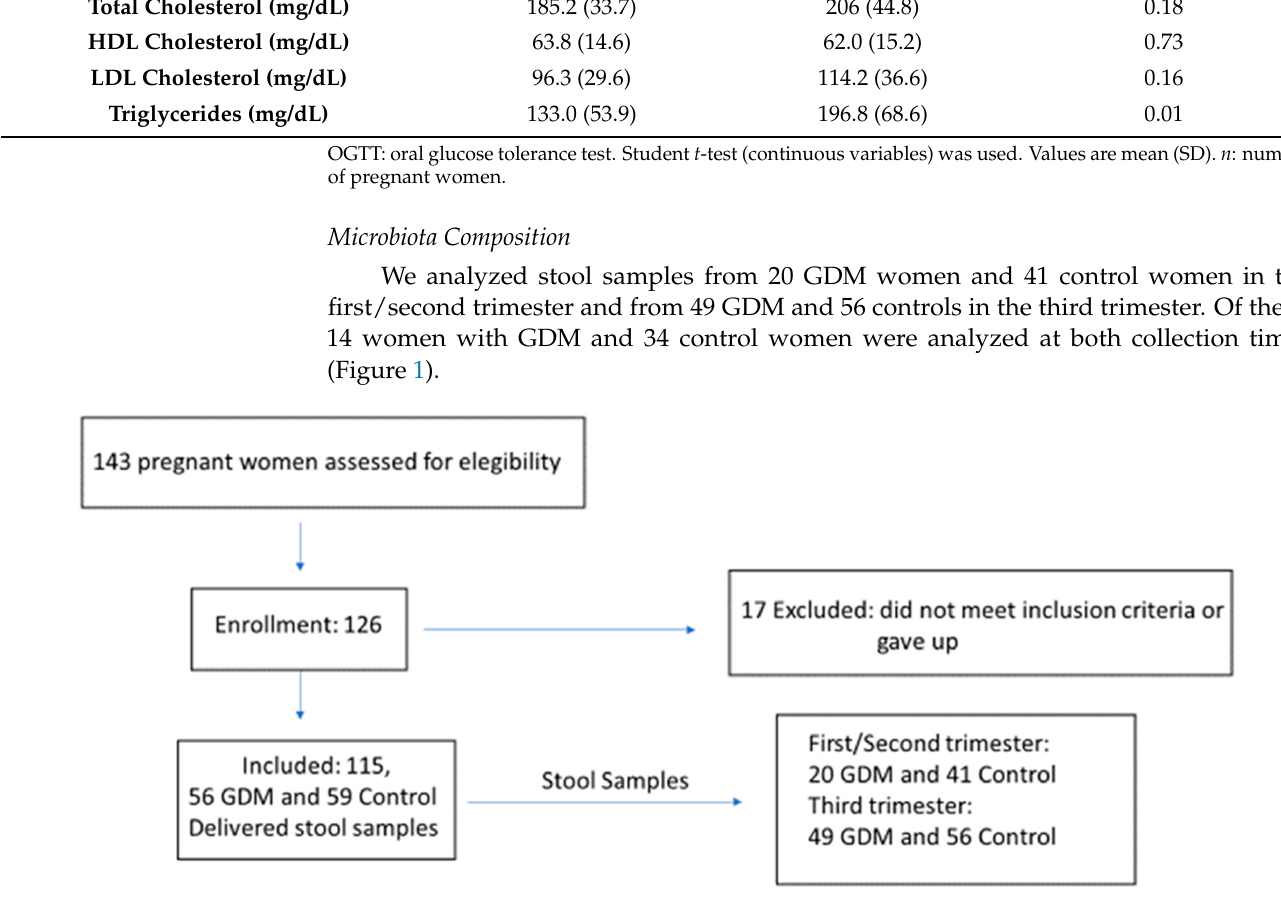
Figure 1. Study Figure 1. Study flowchart.